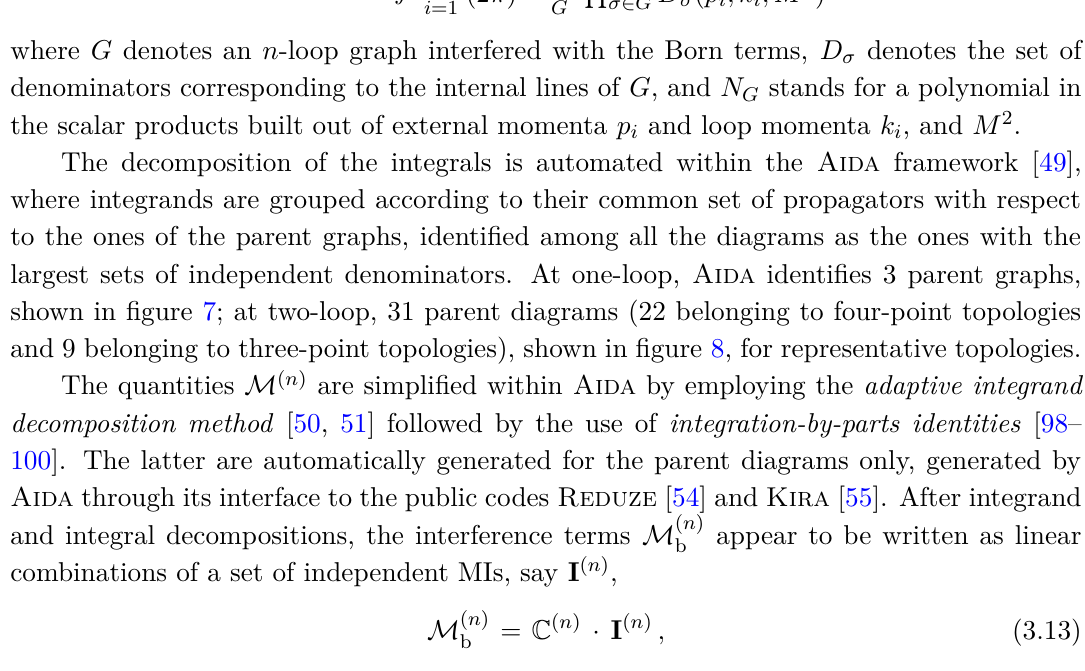
Figure 8 . Representative two-loop parent graphs for the process q ¯ q → Q indicate massless [massive]